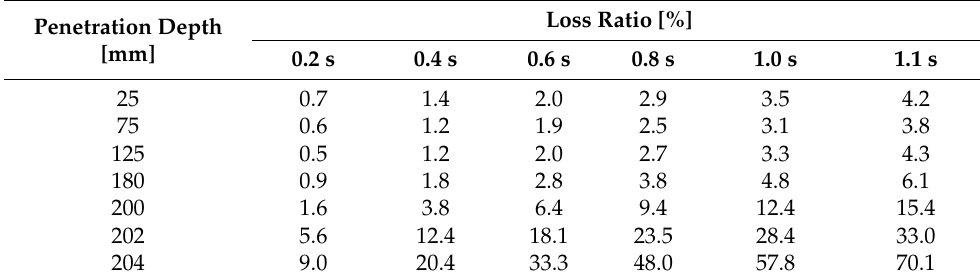
Figure 15. History of wear shapes for each penetration depth. Table 4. Loss ratio of cross-sectional area according to moving distance. Table 4. Loss ratio of cross-sectional area according to moving